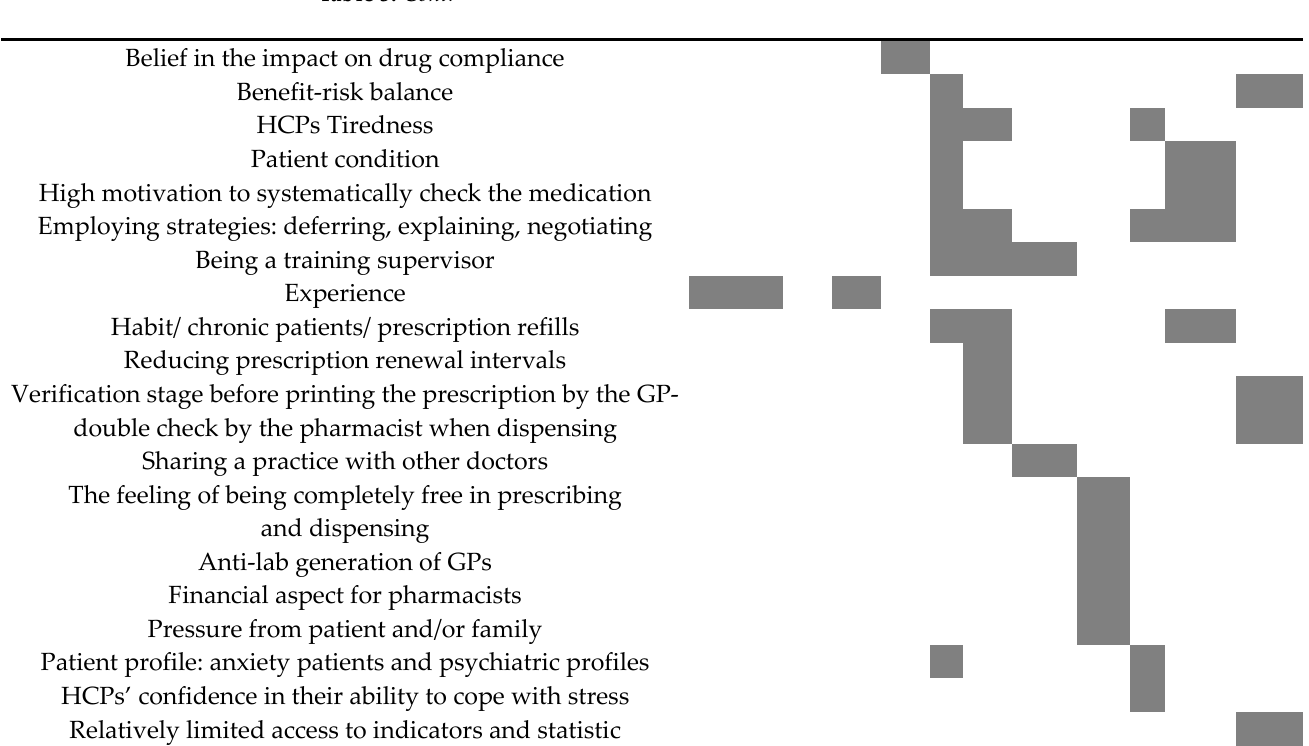
Table 4. Description of the TDF key domains selected according to the bibliographic reference